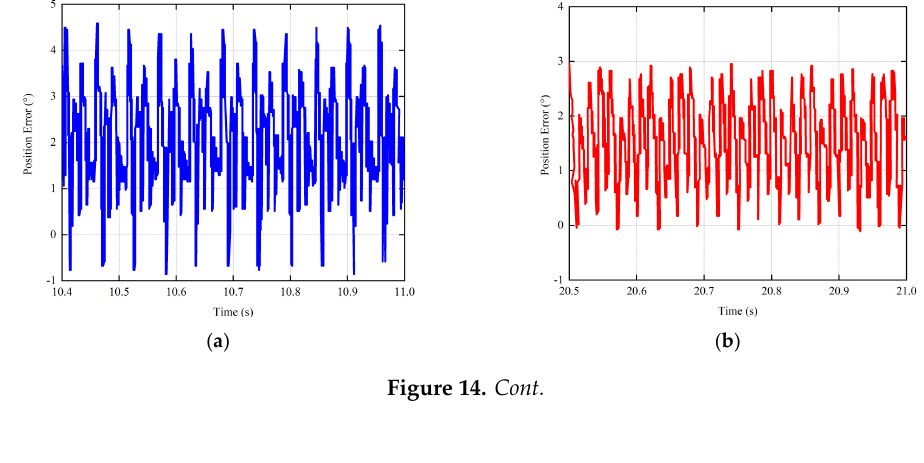
( c ) Current response in q axis before compensation; ( d ) Current response in q axis after compensation.